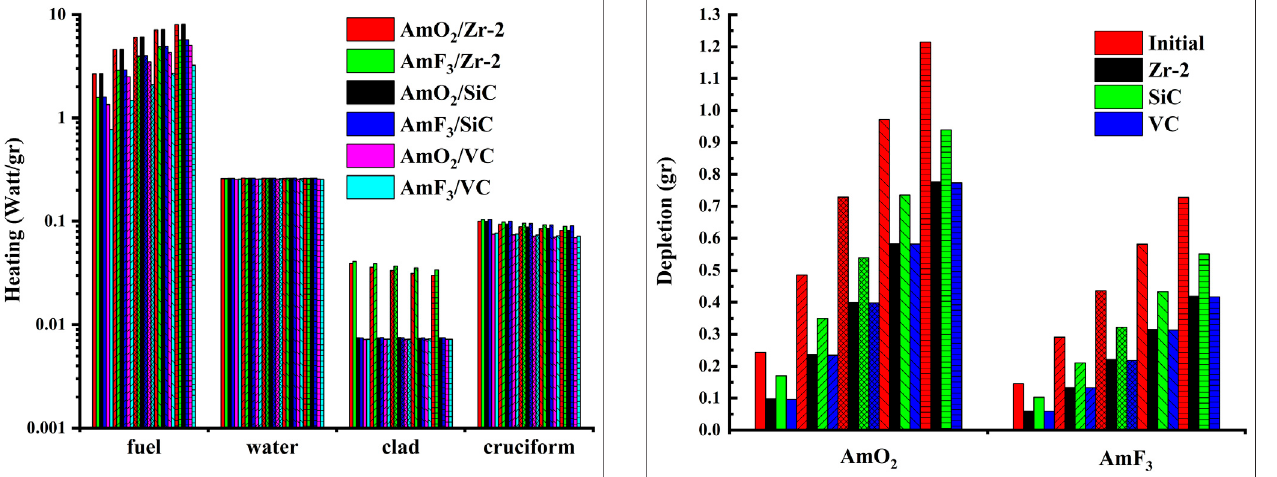
FIGURE8| ThedepletedAmvaluesforZr-2, SiC,andVC clads,thefuel components AmO 2 and AmF 3 ( 0.02%, 0.04%, 0.06%, 0.08%, 0.1%) in the BWR system (the red color indicates the initial Am amount before the fuel is discharged; the black, green and blue colors indicate the depleted Am amount after the fuel is discharged for the